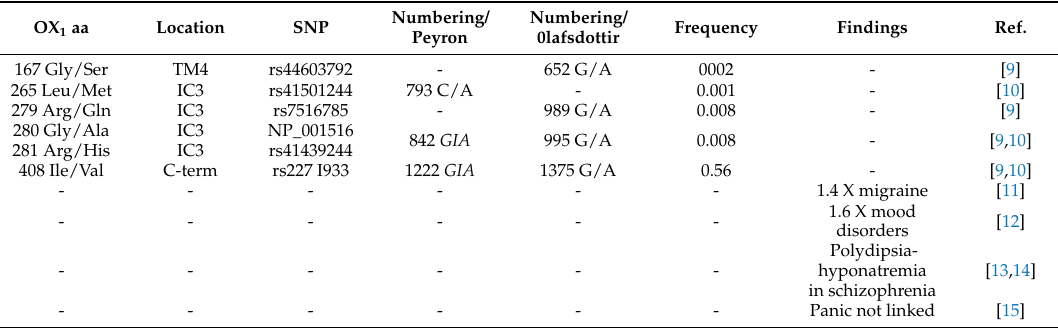
Table 1. OX 1 orexin receptor variants investigated in disease. aa, amino acid; IC, intracellular loop;